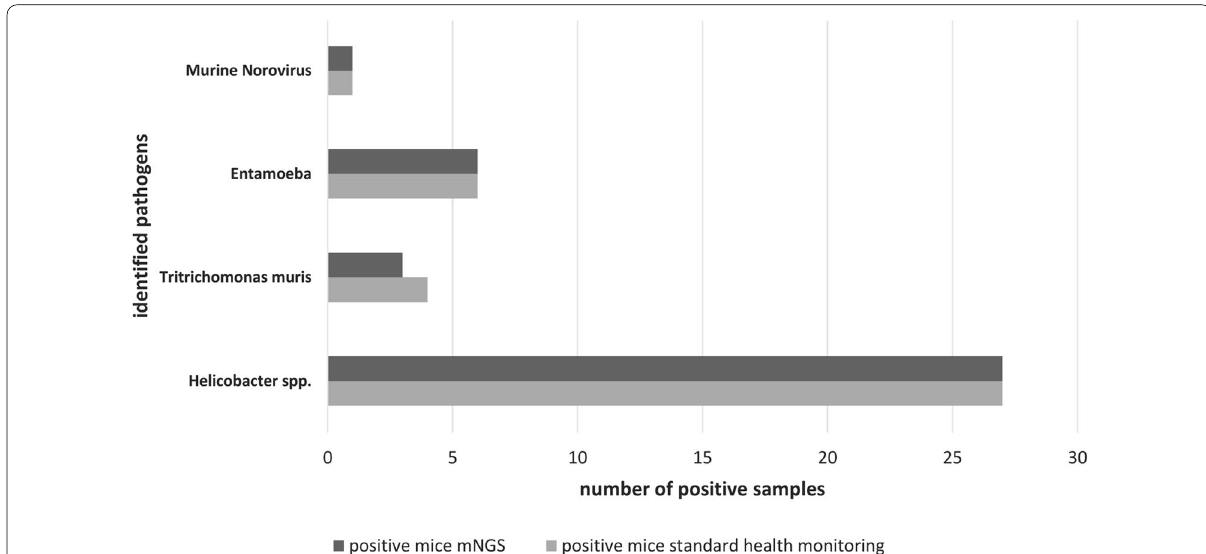
Fig. 5 Comparison between metagenomic data and results from health monitoring assays employed for pathogens detection. Number of positive samples from standard health monitoring assays (light gray bars) and from mNGS analyses (dark gray bars) for the different pathogen species. x axis: number of samples positive for the indicated pathogen; y axis: identified pathogens. Results obtained by NGS are in line with data resulting from health monitoring assays as described in materials and methods except for one sample